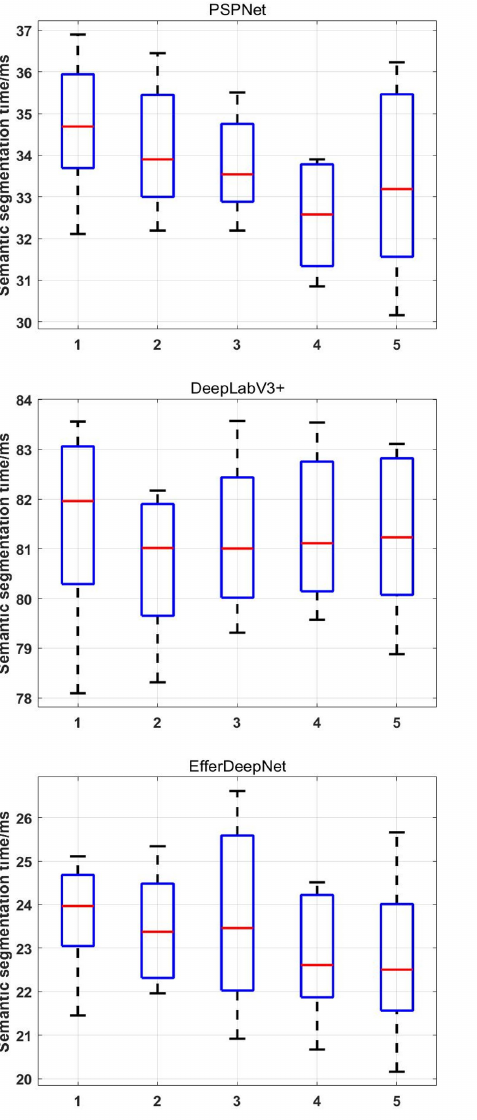
Figure 13. Average semantic segmentation time of different